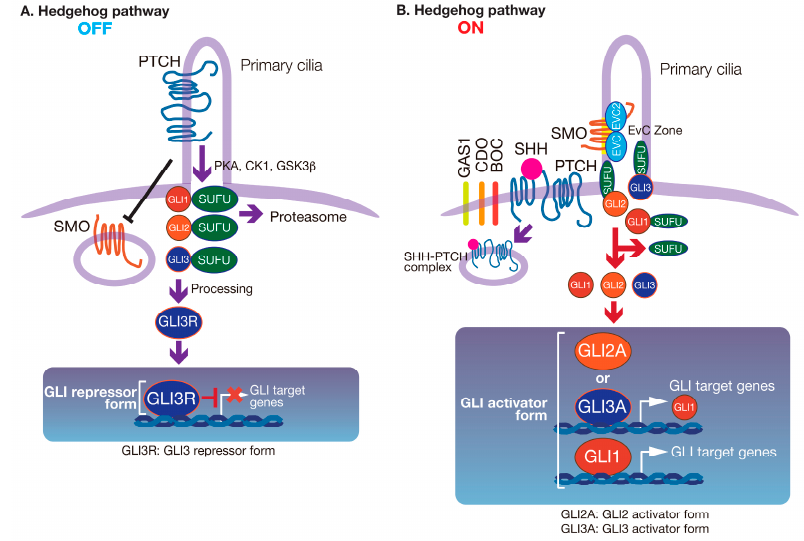
Figure 1. The Hedgehog signaling pathway. ( A ) In the absence of Hedgehog (HH) ligand, Patched (PTCH) blocks the ciliary localization of Smoothened (SMO), and a repressor form of GLI (mainly GLI3R) suppresses the induction of GLI target genes. ( B ) Signaling is activated in the presence of HH ligand. The binding of HH ligand to PTCH prevents PTCH inhibition of SMO, and SMO then interacts with the Ellis van Creveld Syndrome (EVC)–EVC2 complex and translocates into primary cilia to be fully activated. SMO then activates GLI family transcription factors, mainly GLI2. GLI2 up-regulates the expression of GLI1, as well as GLI target genes. GLI1 is also activated downstream of SMO. Activated GLI2 (GLI2A) and GLI1 further upregulate the expression of various GLI target genes. This figure has been adapted from our previous work